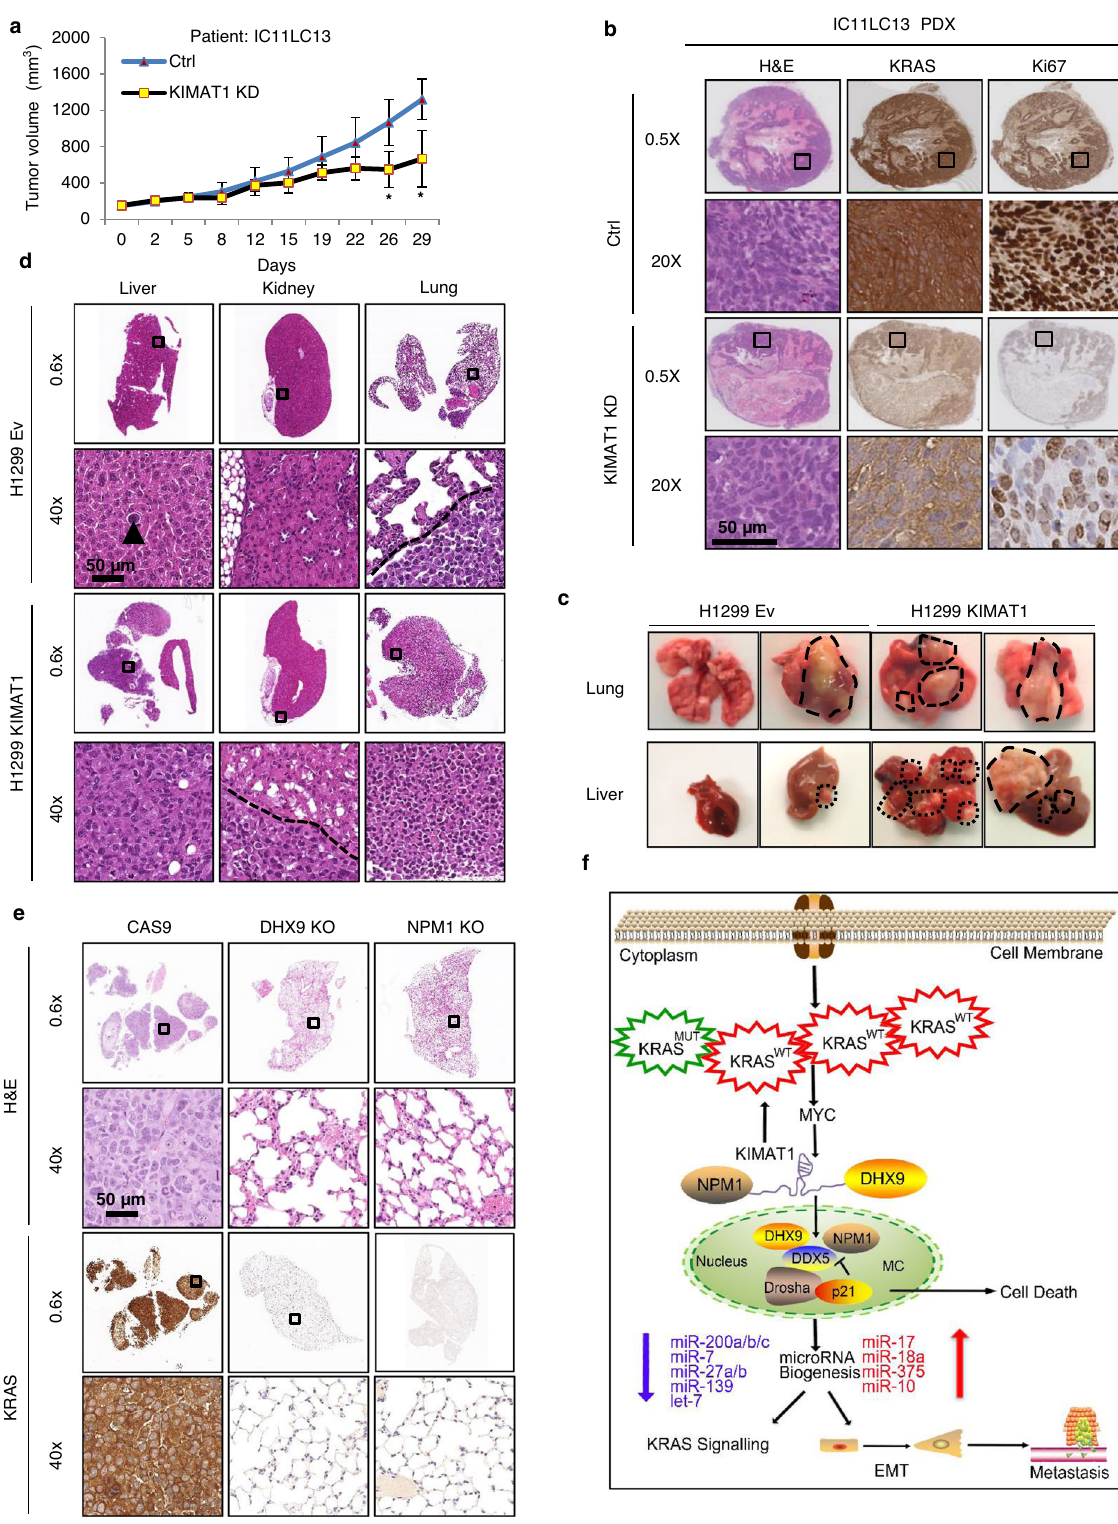
13,000× g for 20min at 4 o C. Protein concentration was measured by SpectraMax M5 (SoftMax Pro6) using the Pierce BCA Assay Kit (ThermoFisher Scienti fi c). Super- natant was used for immunoblotting with the indicated antibodies. Signal was detected using Western Bright ECL-Spray substrate and ChemiDoc instrument (Bio-Rad). RNA extraction and quantitative real-time PCR (qRT-PCR) . Total RNA was isolated from cells and tissues using TRIzol according to the manufacturer ’ s instructions. For miRNA detection, 50 ng of RNA was reverse-transcribed using